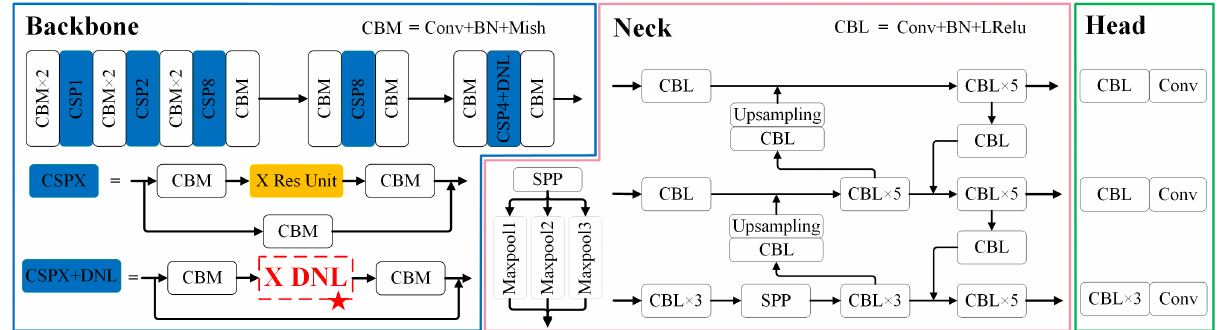
Figure 4. The specific details module of the YOLOv4 network with the DNL module added. The YOLOv4 network model consists of three parts: backbone, neck, and detection head. This arti- cle mainly modified the backbone module, adding the DNL module to the some CSPX